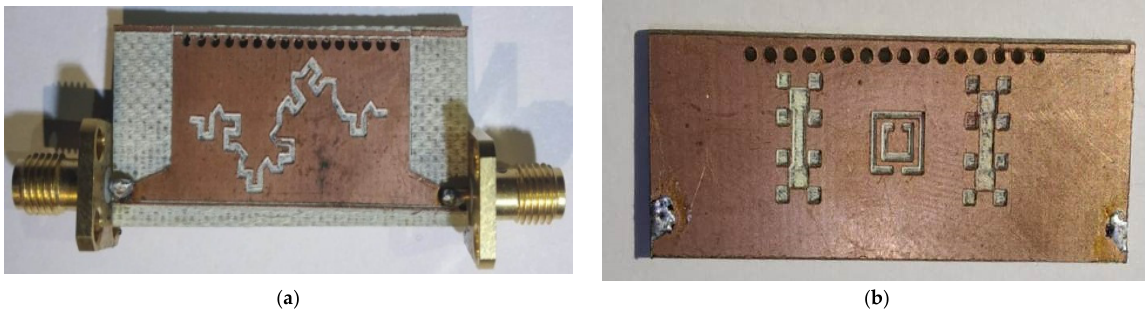
Figure 13. ( a ) Top and ( b ) bottom views of fabricated band pass filter.